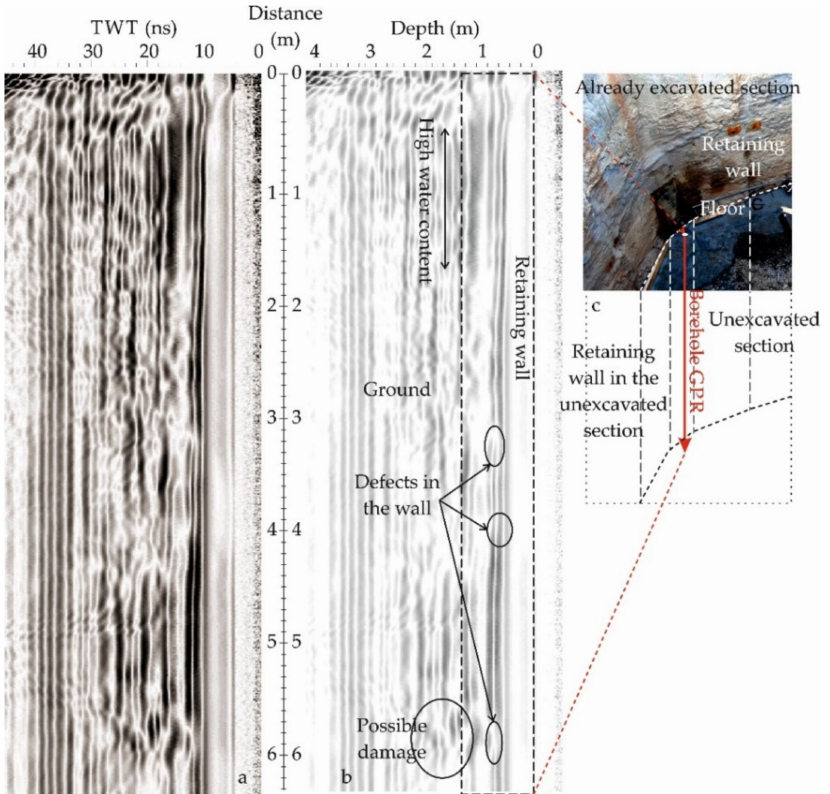
Figure 8. Borehole GPR images. ( a ) Radargram. ( b ) Data interpretation. ( c ) The excavation and the position of the GPR borehole. The images allow one to determine the contact between the wall and the ground, as well as zones that must be repaired or reinforced before the